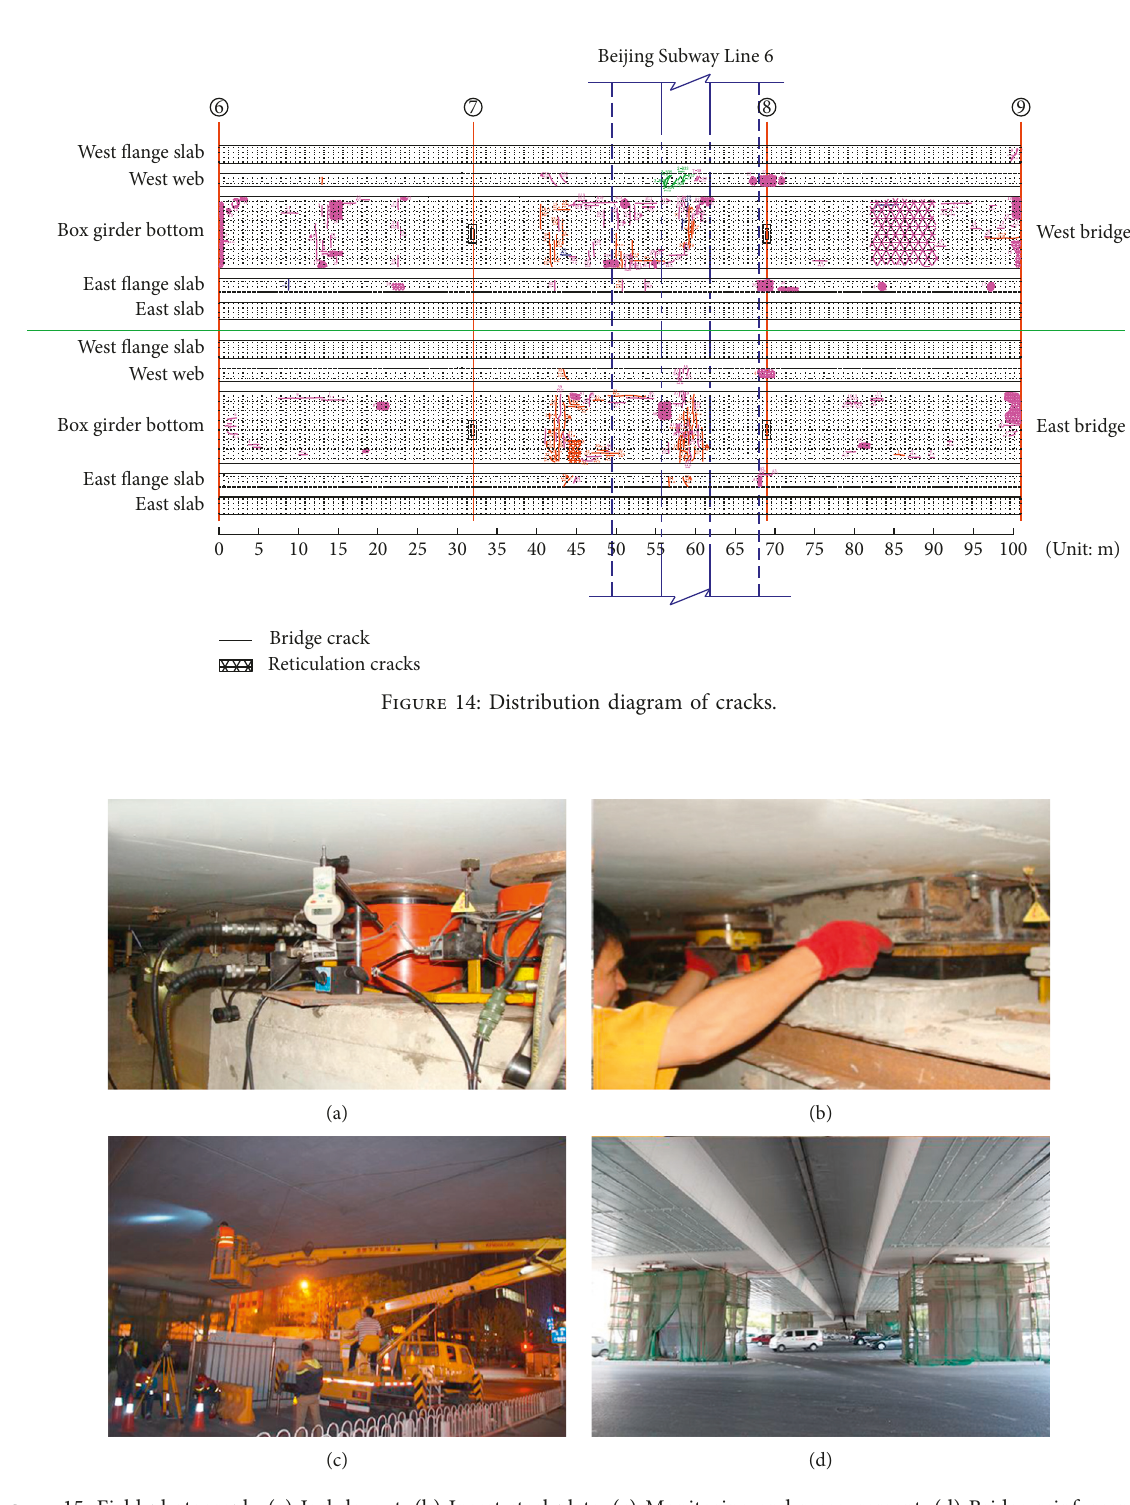
Figure 15: Field photograph. (a) Jack layout. (b) Insert steel plate. (c) Monitoring and measurement. (d) Bridge